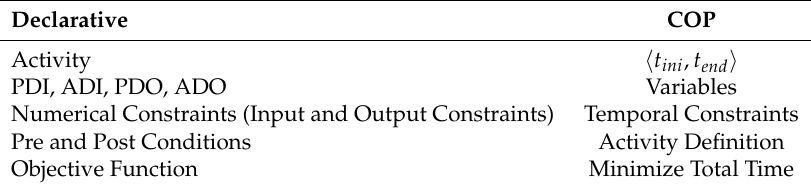
Table 1. Declarative model and COP elements